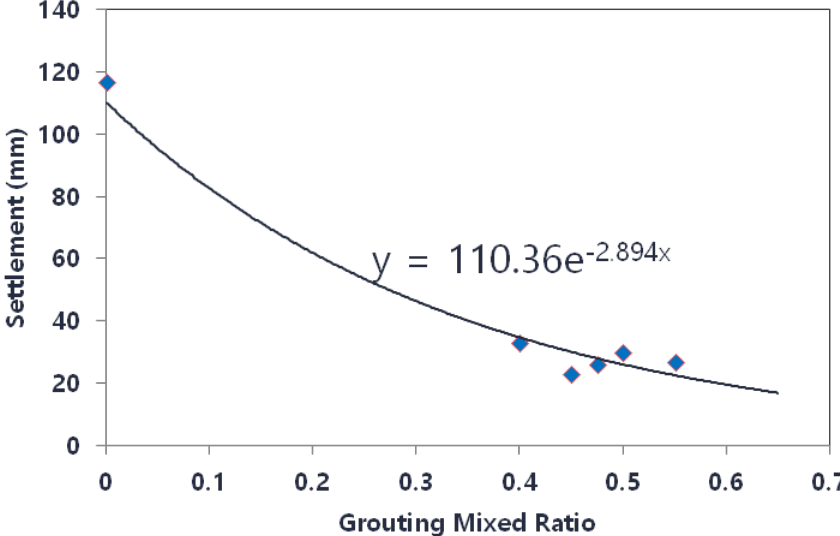
Figure 18. Relationship between settlement and grouting mixing ratio.